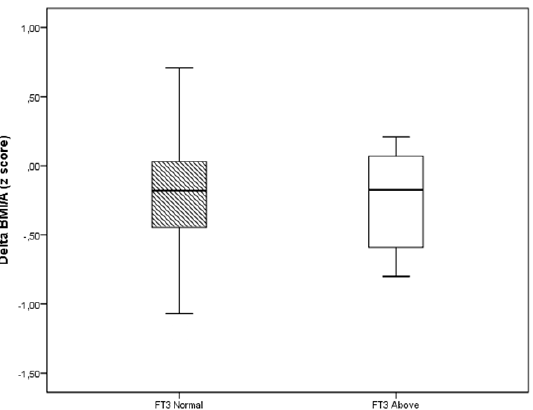
Figure 2. Delta of BMI / A (z score) based on the FT3 values at follow-up. The line represents the median (interquartile interval). Mann–Whitney test, p = 0.723.